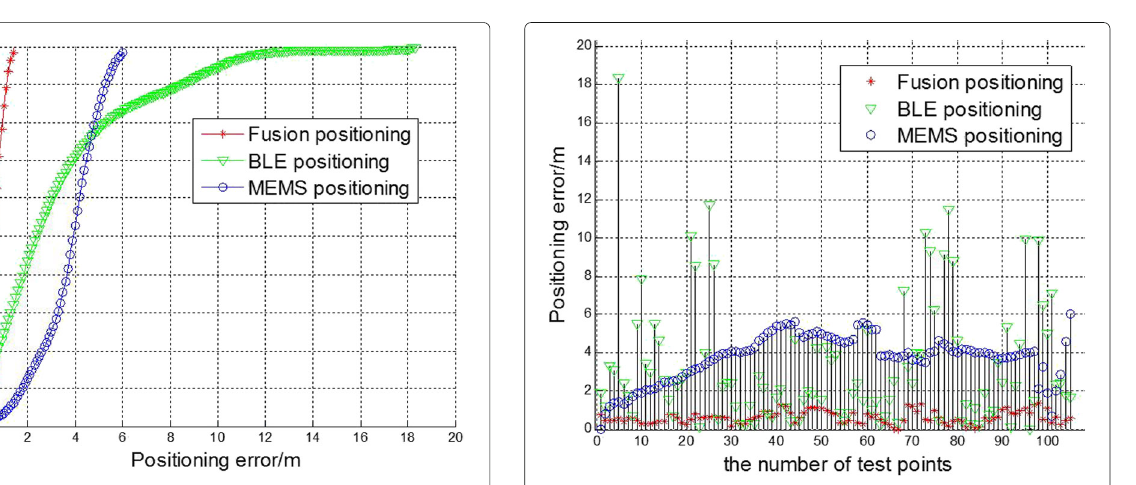
Fig. 28 CDF of positioning errors